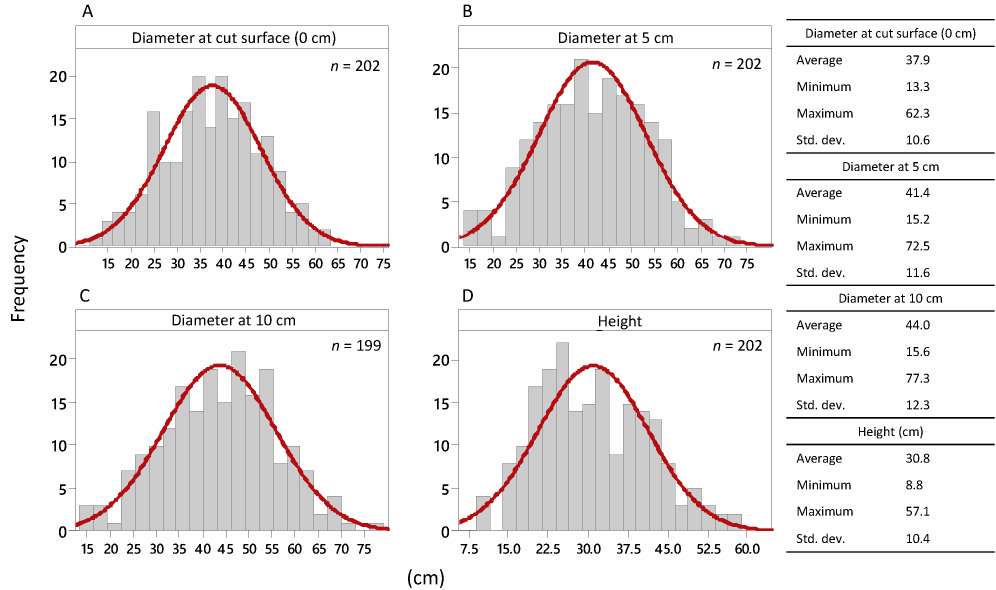
Figure 4. Frequency distributions for ( A ) stump diameters at cut-surface; ( B ) stump diameters at the 5 cm surface; ( C ) stump diameters at the 10 cm surface, and; ( D ) stump heights.